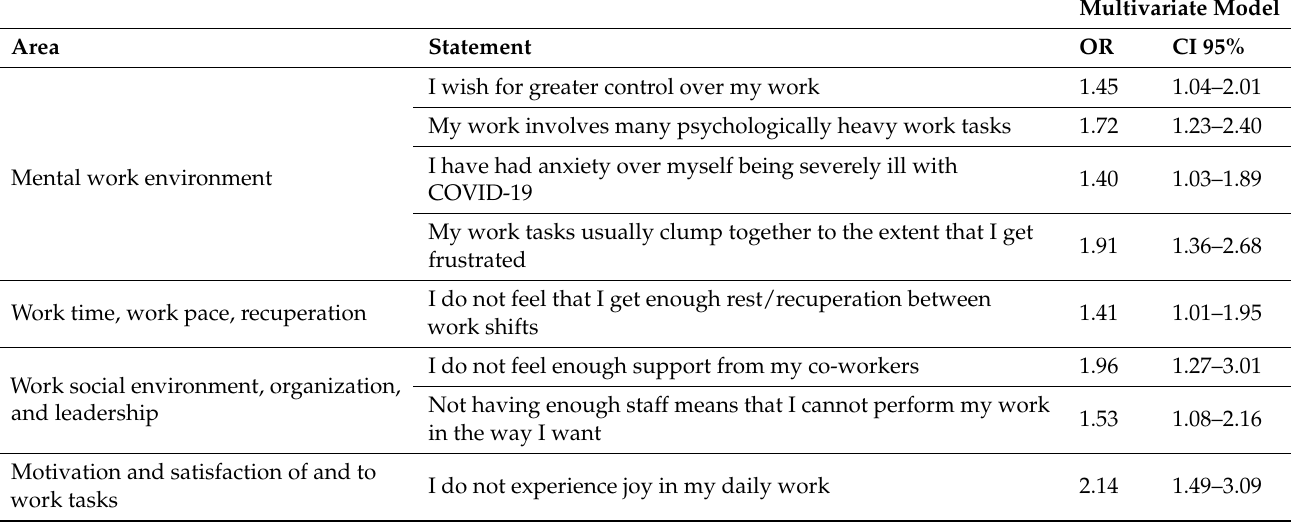
Table 5. Final multivariate model with COVID-19-specific variables. Statistically significant variables in relation to work-related mental health diagnoses in 2020. OR = Odds ratio; CI = Confidence interval. Cox and Snell R Square 0.058; Nagelkerke R square